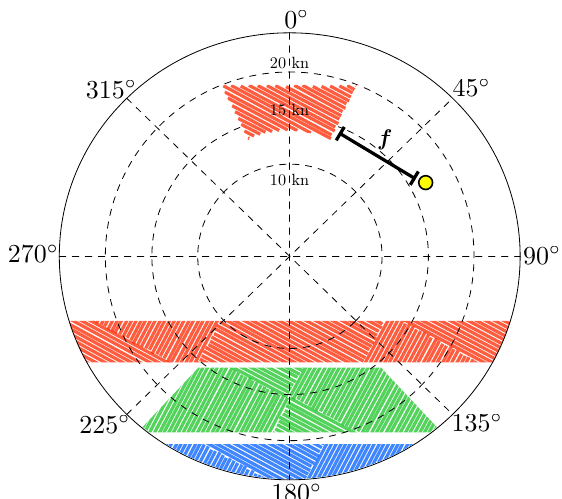
Figure 3. Representation of the dangerous zones according to the guidelines IMO [8]: surf-riding and broaching-to in blue, synchronous rolling and parametric rolling in red and successive high-wave attack in